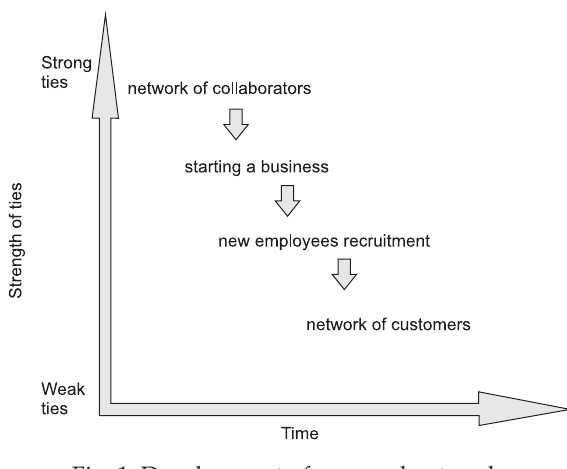
Fig. 1. Development of personal